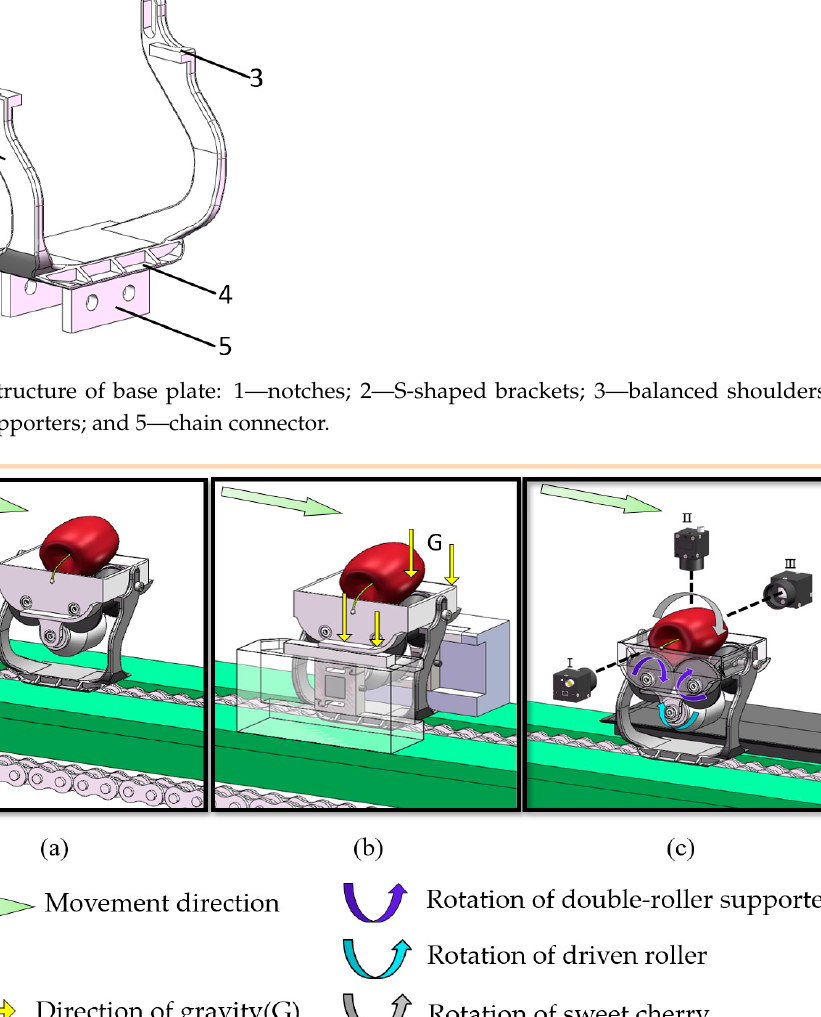
Figure 7. Structure of base plate: 1—notches; 2—S-shaped brackets; 3—balanced shoulders; 4– balanced supporters; and 5—chain connector.